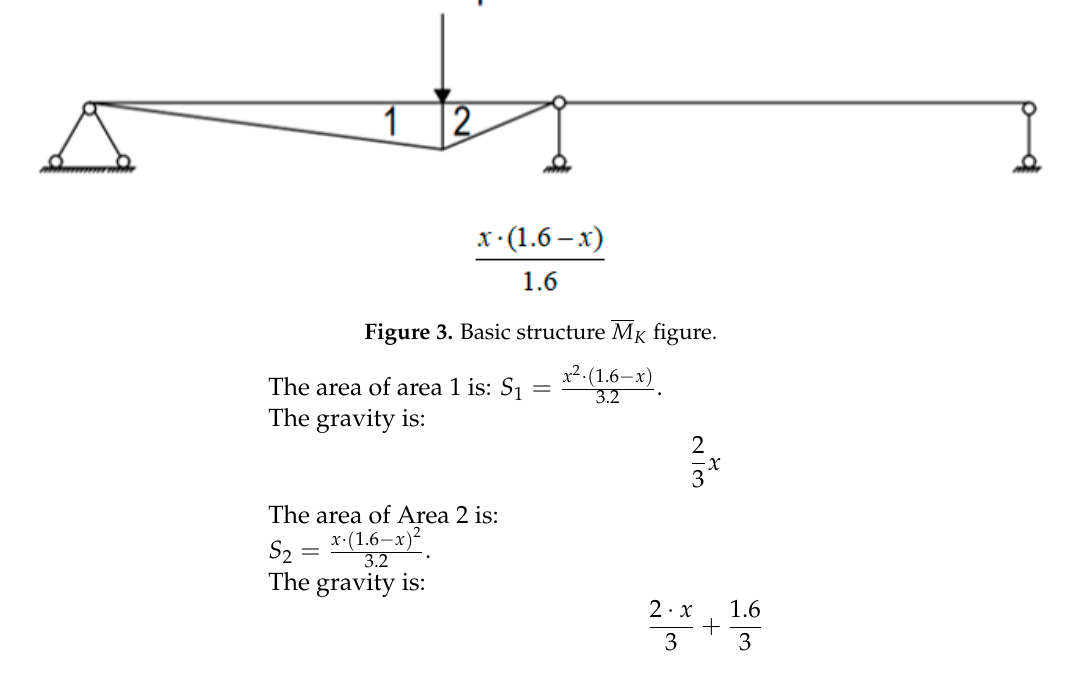
Figure 3. Basic structure figure.